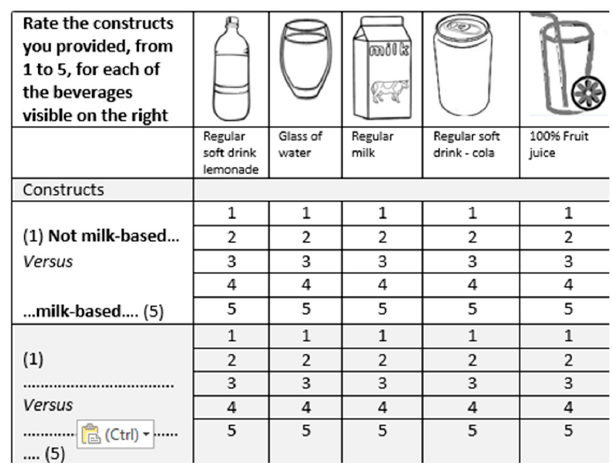
Figure 1. A portion of the bipolar scale on which constructs were recorded. Images have been changed to sketches to protect copyright.